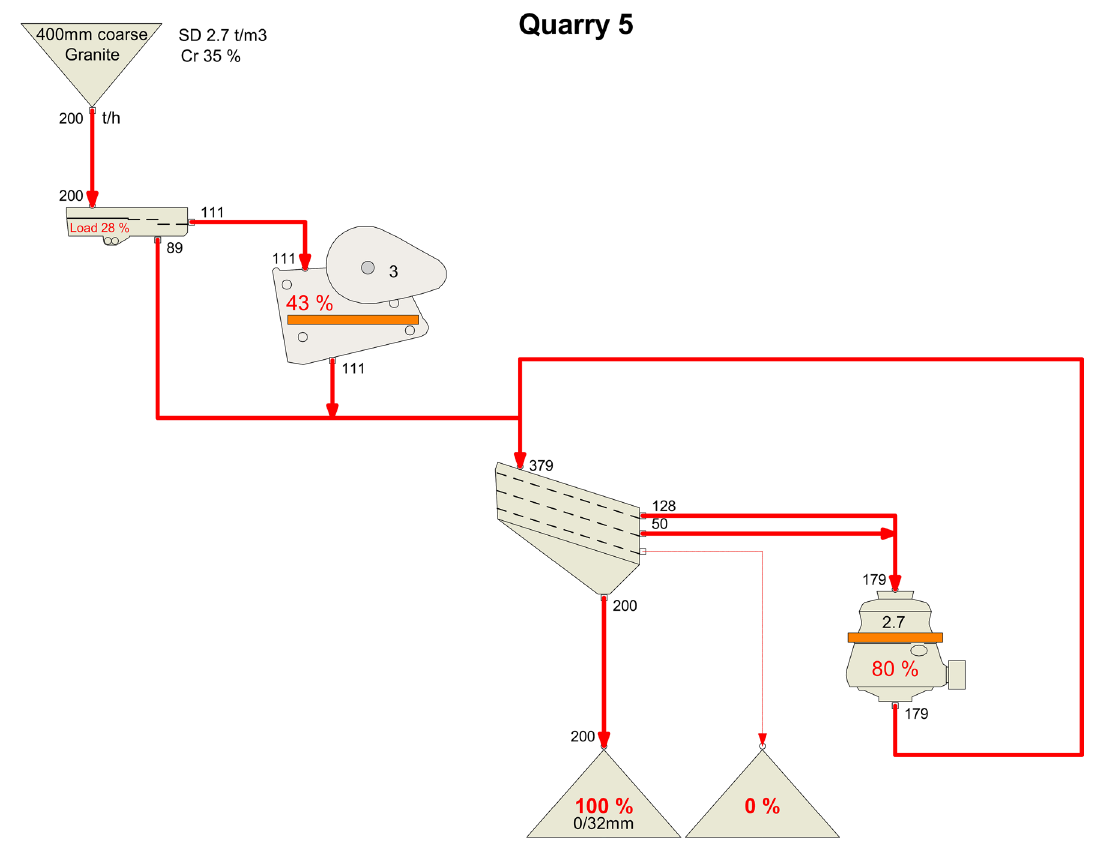
Fig. 1 The quarry 5 crushing and screening process flow. Two crushing stages, primary jaw crusher and secondary cone